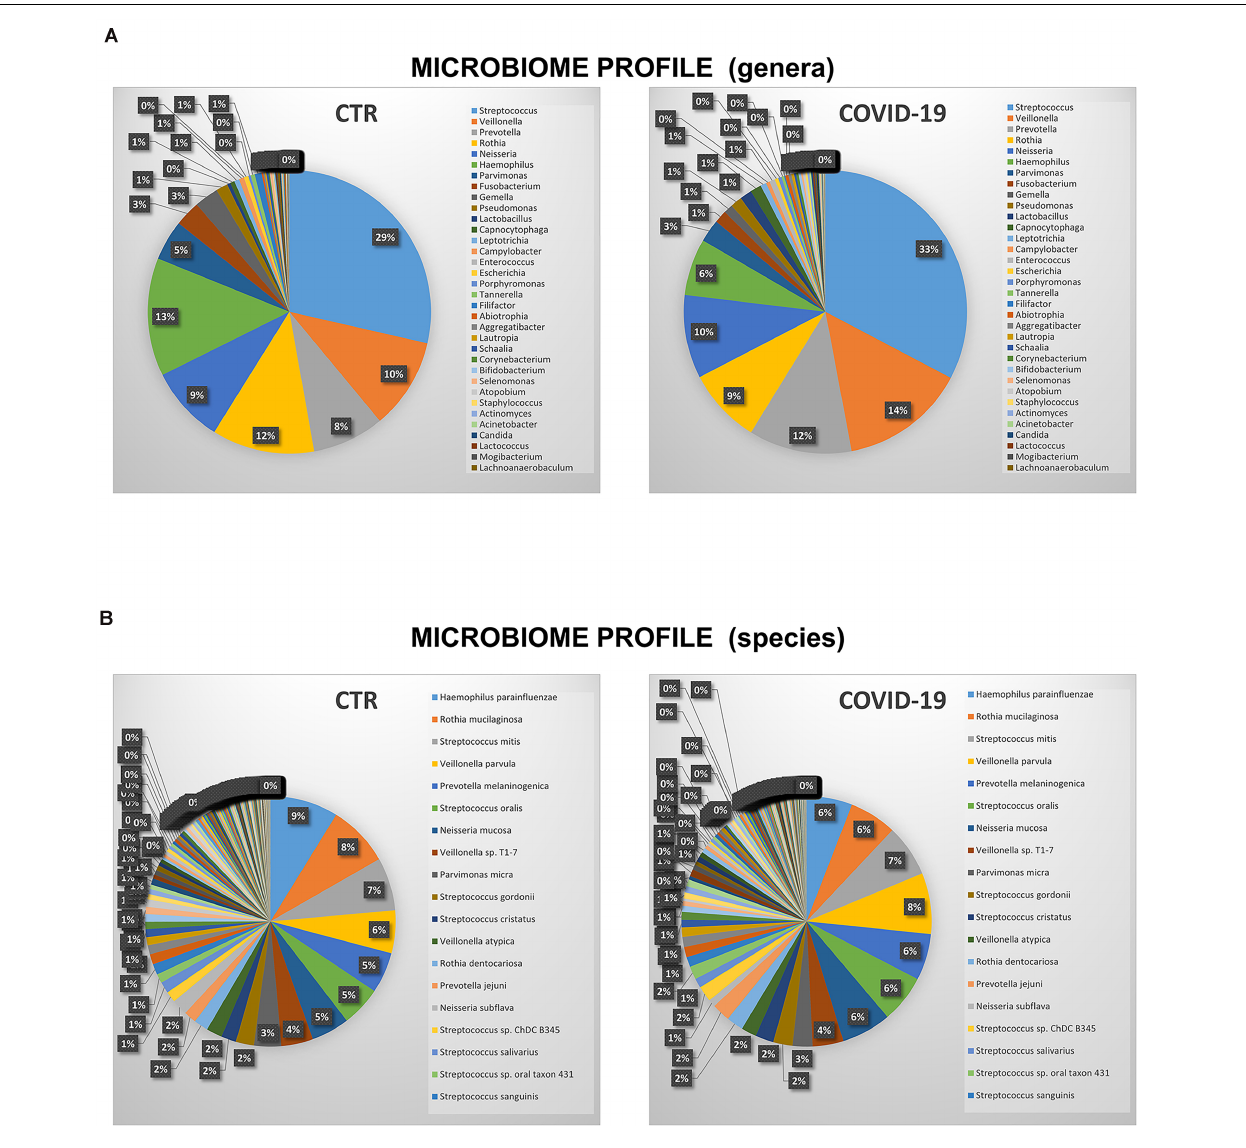
FIGURE 3 | Relative abundance and distribution of microorganisms in the oral cavity of control (CTR) and COVID-19 subjects. (A) Percentage distribution of most detected microbial genera. (B) Percentage distribution of most detected microbial